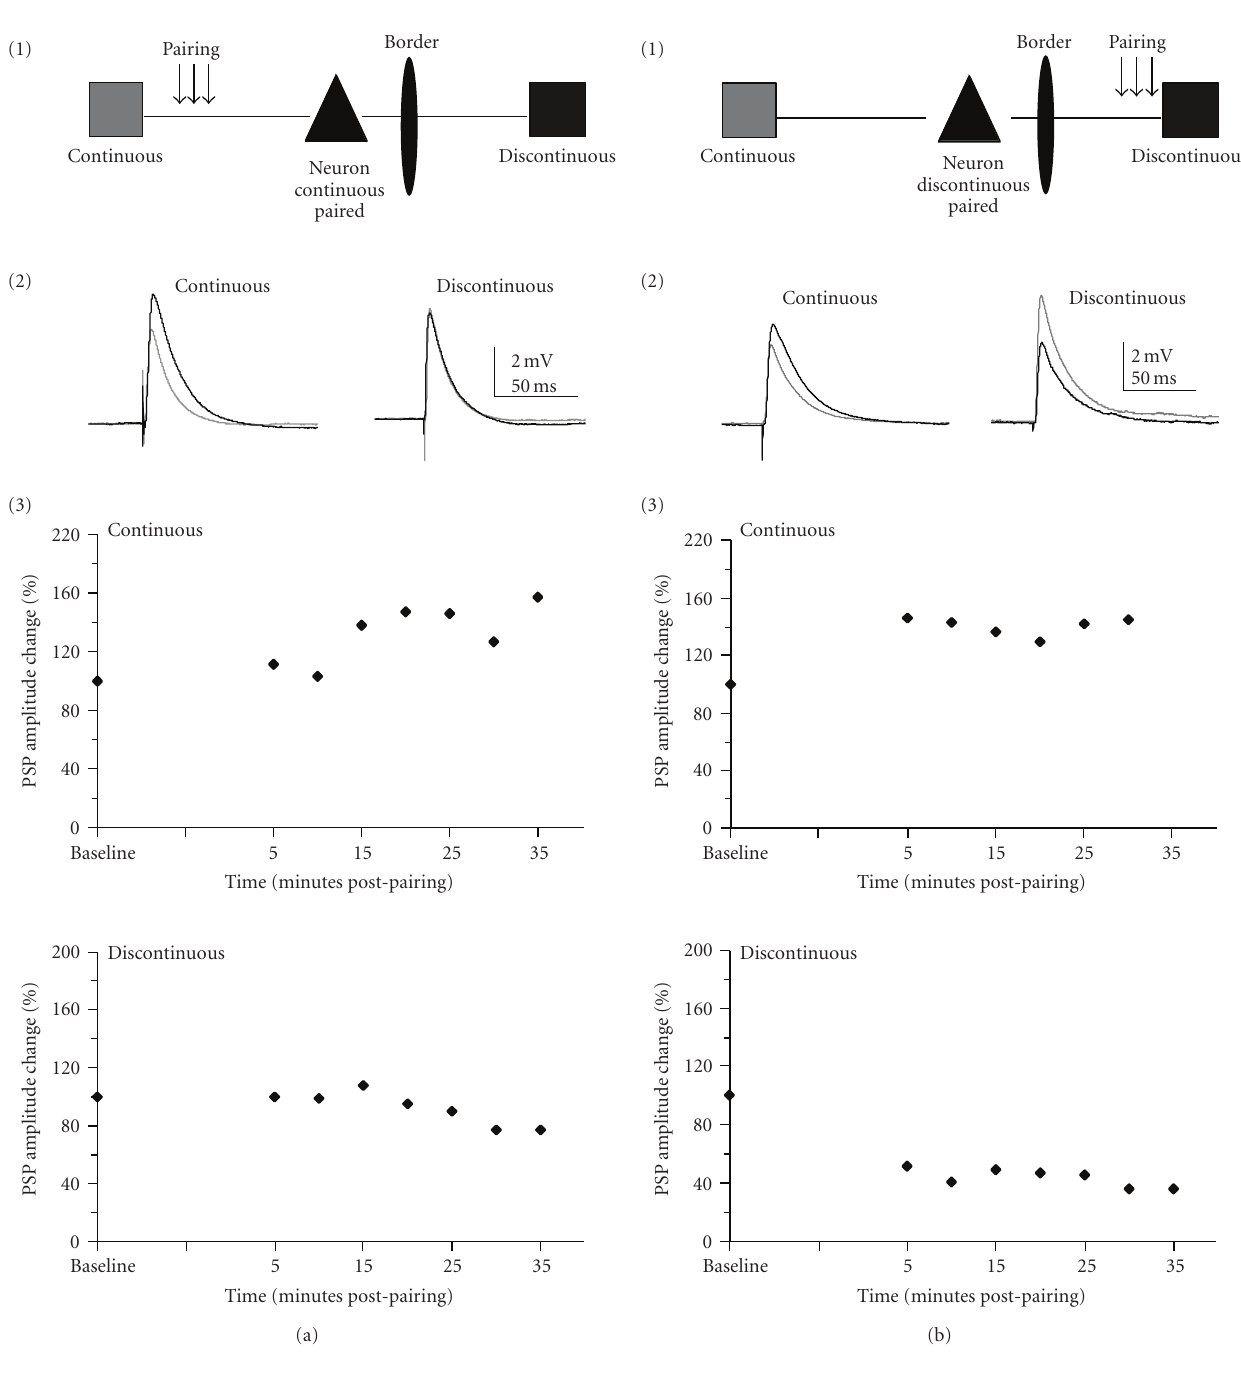
Figure 2: Changes in PSP amplitude generated by one pathway pairing. (a) Sixteen neurons underwent pairing of continuous representation connections only. (b) Fourteen neurons underwent pairing of discontinuous representation connections only. (1) Schematic of pathway pairing paradigm. (2) Example responses from a cell in which pairing of the indicated pathway induced homosynaptic (a) or homo- and heterosynaptic (b) enhancement of the pathways. Traces are averaged over five minutes. Grey traces are averaged PSPs from before pairing (baseline) and the black traces are averaged PSPs from 20 minutes postpairing. (3): % change of PSP amplitude over time for the cell shown in (2). PSP amplitude change was averaged over five minute